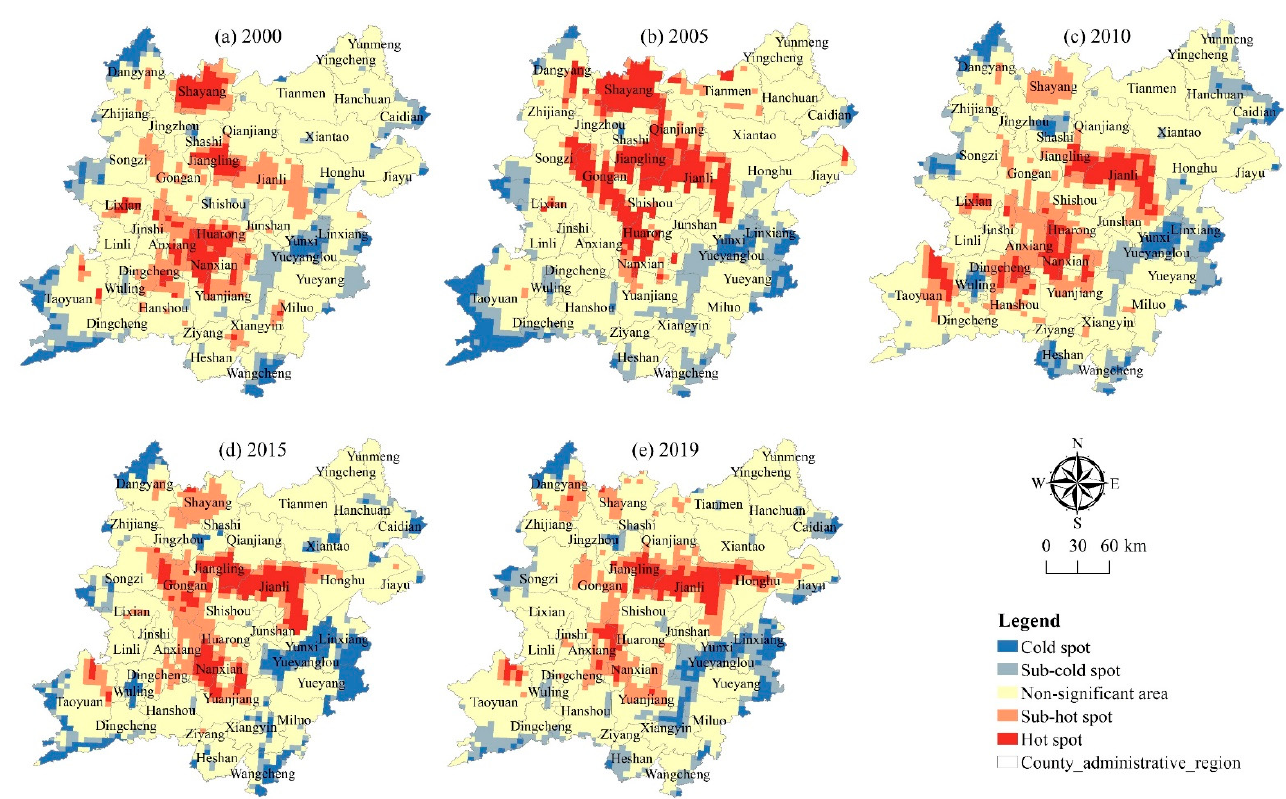
Figure 5. Spatial pattern of cold and hot spots of status index in the two lake plains from 2000 to 2019.